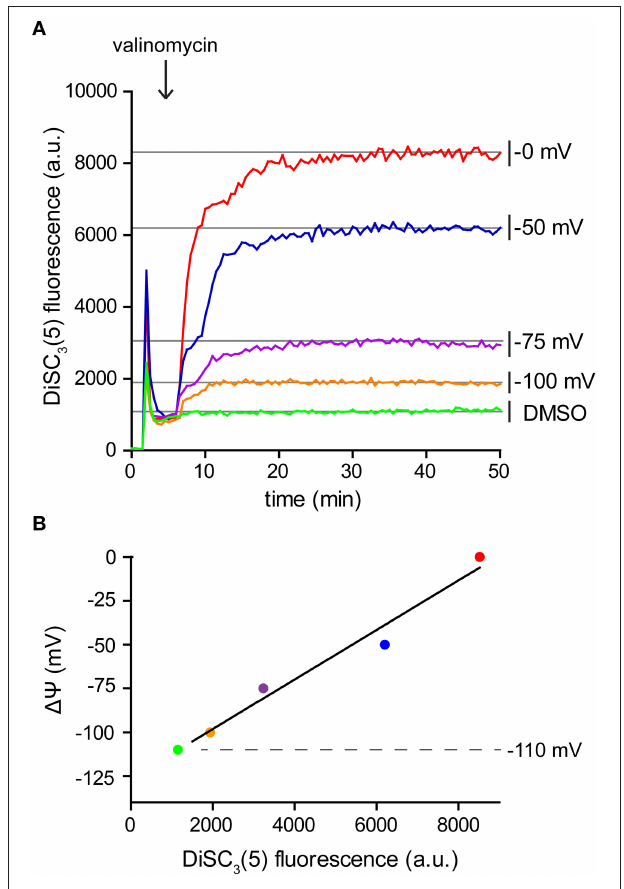
FIGURE 4 | Calibration of DiSC 3 (5) assay. (A) Fluorescence intensity of DiSC 3 (5) in B. subtilis cell suspensions in media with varying K + concentrations. Upon addition of K + carrier valinomycin (4 µ M), membrane potential reaches stable levels pre-determined by the K + gradient across the membrane (see Table 2 ). The time point of valinomycin addition is highlighted with an arrow. (B) The fluorescence levels obtained from the experiment shown in panel (A) can be used to calibrate the arbitrary DiSC 3 (5) fluorescence values. The estimated membrane potential for untreated B. subtilis cells ( − 110mV) is indicated with a dashed line. Strain used: B. subtilis 168 (wild